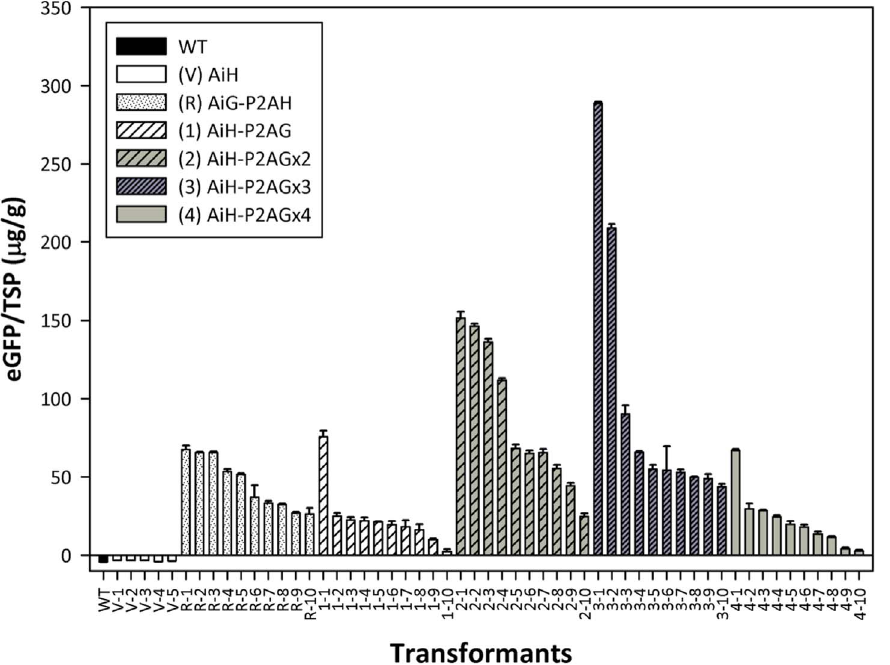
Figure 5. EGFP production of mycelia for wild type and transformant F.velutipes . TSP: total soluble protein. The EGFP assays were repeated three times. The error bars indicate the standard